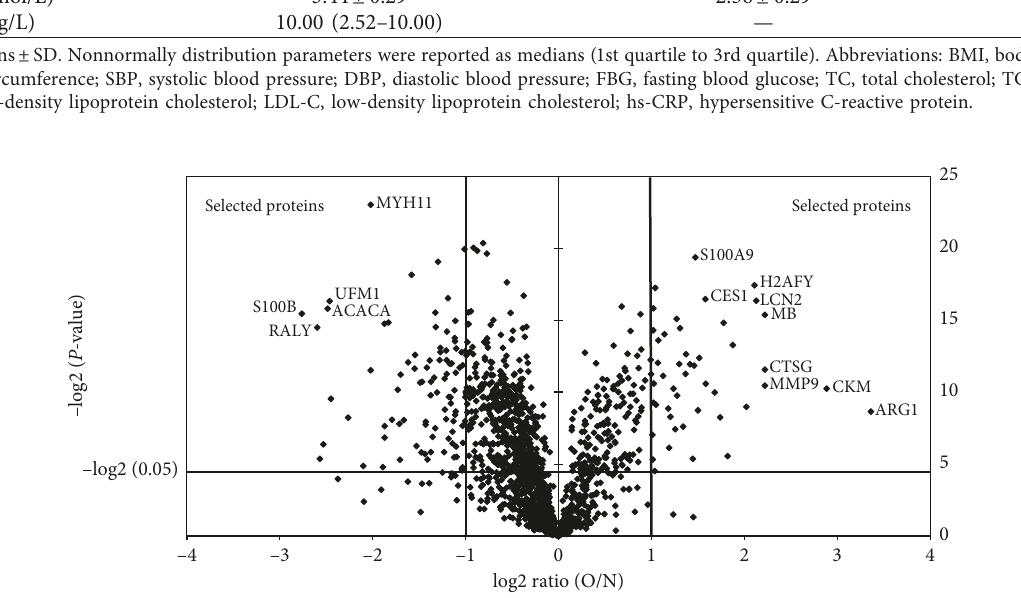
Figure 2: Volcano plot of the protein differences. The volcano plot illustrates the protein differences. The significantly expressed proteins are located above the horizontal line and on the outer side of the vertical lines. In this volcano plot, the horizontal line represents the 0.05 nominal significance level for protein expression. Vertical lines sort out proteins with at least a twofold difference between morbidly obese and normal weight subjects. Some most significantly changed proteins were identified and named in the figure. Abbreviations: O/N: obese/ normal weight; MYH11, myosin-11; UFM1, ubiquitin-fold modifier 1; ACACA, acetyl-CoA carboxylase 1; S100B, protein S100-B; RALY, RNA-binding protein Raly; S100A9, protein S100-A9; H2AFY, core histone macro-H2A; CES1, liver carboxylesterase 1; LCN2, neutrophil gelatinase-associated lipocalin; MB, myoglobin; CTSG, cathepsin G; MMP9, matrix metalloproteinase-9; CKM, creatine kinase M-type; ARG1,